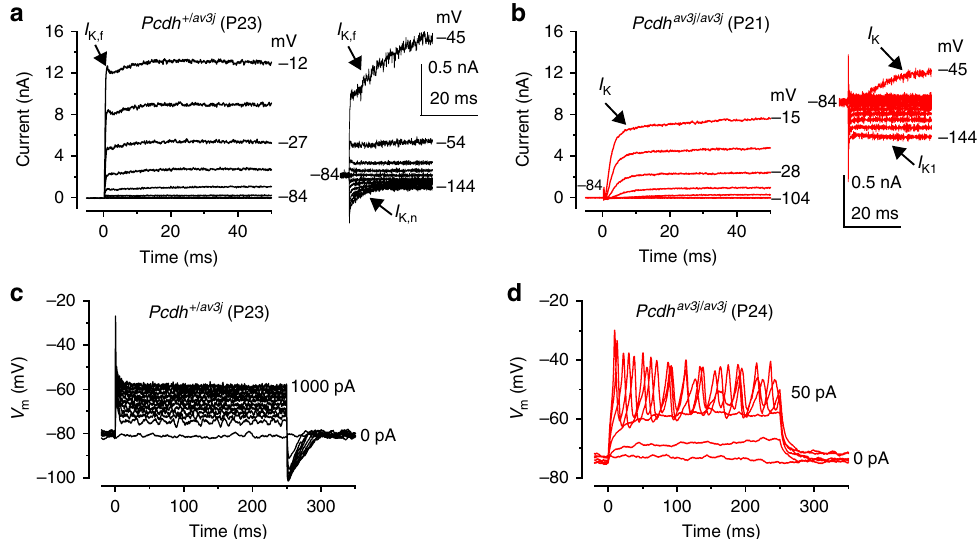
Fig. 1 Current and voltage responses from IHCs of Pcdh15 mutant mice. a , b Potassium currents recorded from IHCs of control Pcdh15 + /av3j ( a ) and littermate mutant Pcdh15 av3j/av3j mice ( b ) using 10 mV depolarizing voltage steps from – 84 mV to the various test potentials shown by some of the